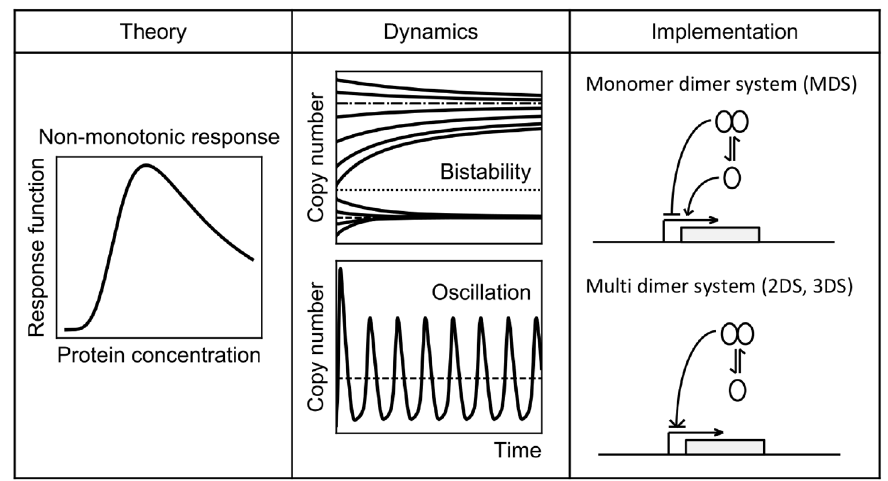
Fig 2. Theory, dynamics and implementation of non-monotonic response curves. Non-monotonic response curves with a maximum can lead to different types of dynamics such as bistability and oscillations. The most simple one gene implementations for such a non-monotonic response are the monomer dimer system (MDS) and multi dimer systems (details in Materials and methods).